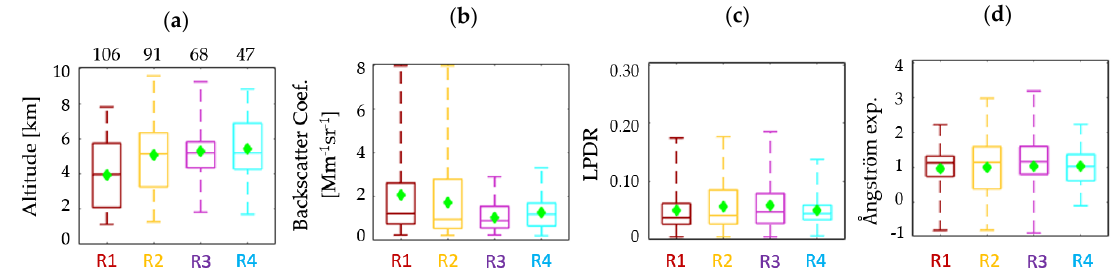
Figure 9. Pure smoke aerosol layers according to ( a ) their altitude (amsl.) and relevant optical properties: ( b ) β at 532 nm, ( c ) LPDR at 532 nm, ( d ) AE related to β (532 / 1064 nm). R1–R4 correspond to the four subregions.